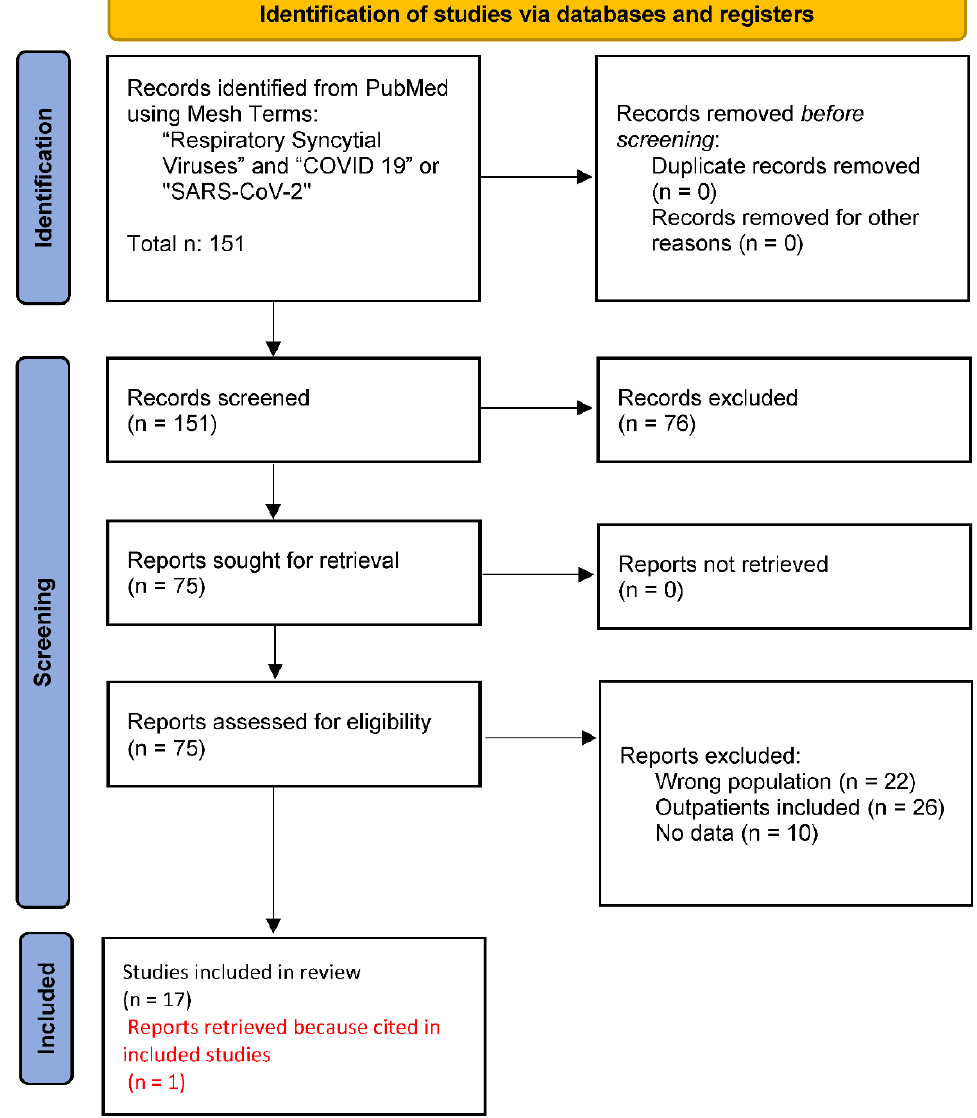
Figure 1. Flow chart of the selected process, according to PRISMA guidelines: 151 reports were selected from PubMed, none of which were removed for duplication nor for foreign language. Seventy-six records were excluded by reading their abstracts because they dealt with the wrong topic. Seventy-five reports were analyzed full-length, fifty-seven of which were excluded: twenty-two dealt with the wrong population, twenty-six included outpatients, and ten had no data reported. One relevant report was found cited in another study and, therefore, was added to this research. The included reports had been analyzed and the main highlights are presented in